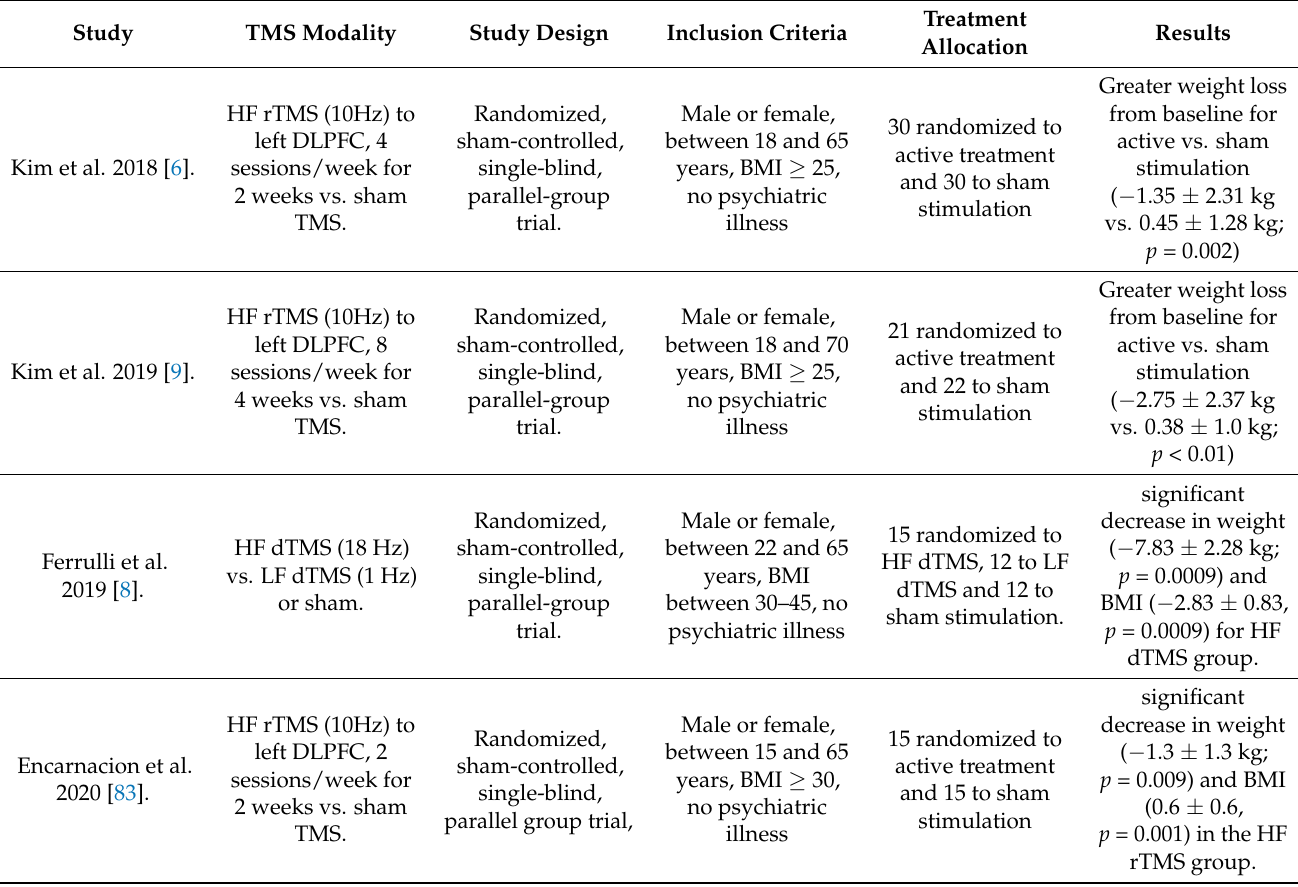
Table 1. Randomized sham-controlled studies of rTMS for weight loss in non-psychiatric